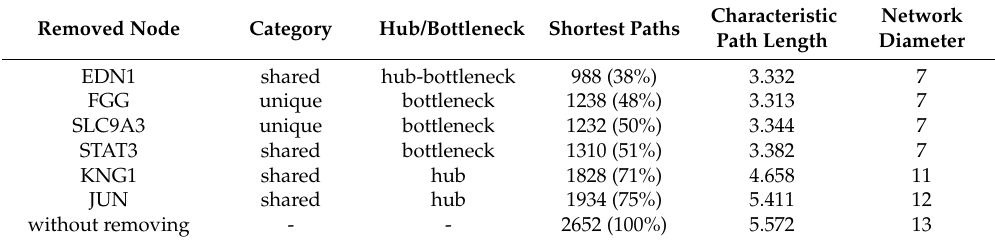
Table 4. Topological parameters of CHD CePIN after candidate targets